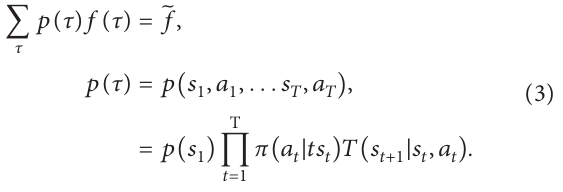
Figure 1: The neural network used to approximate the